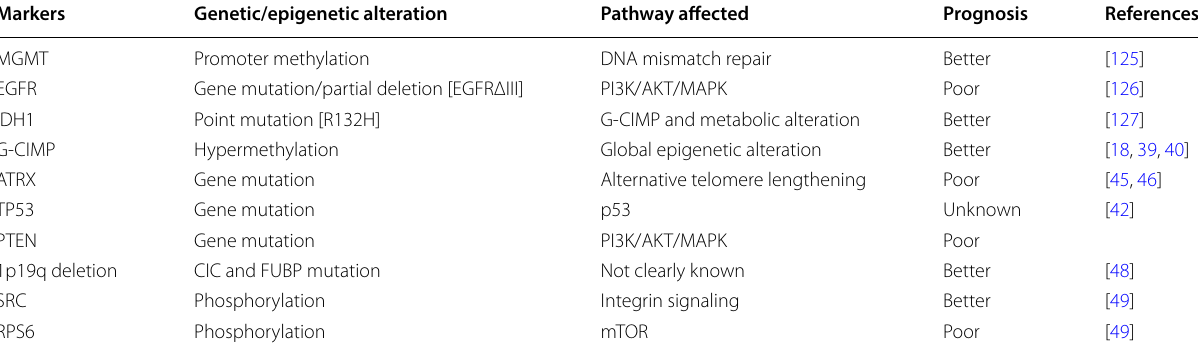
Table 2 Molecular marker based disease prognosis in Glioblastoma multiforme